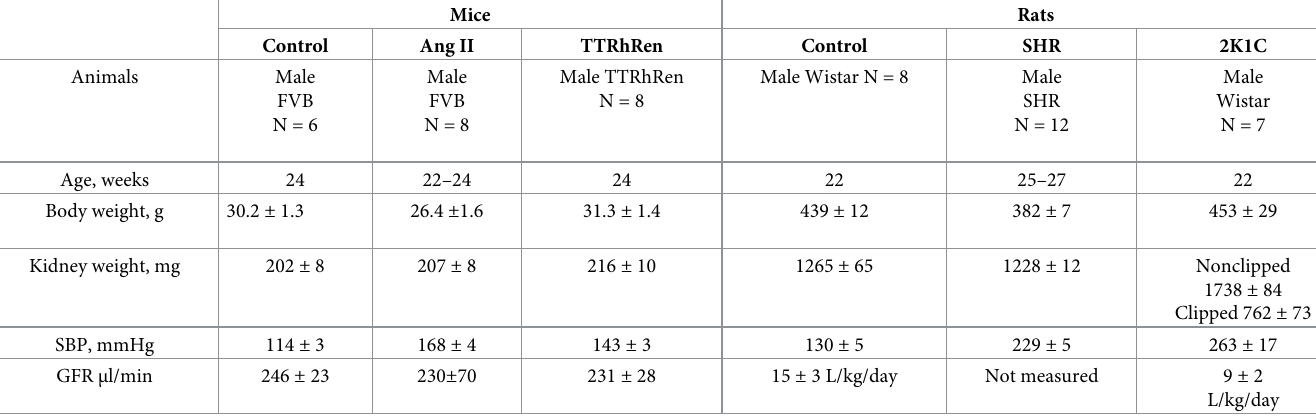
Table 3. Characteristics of the animals at the end of the